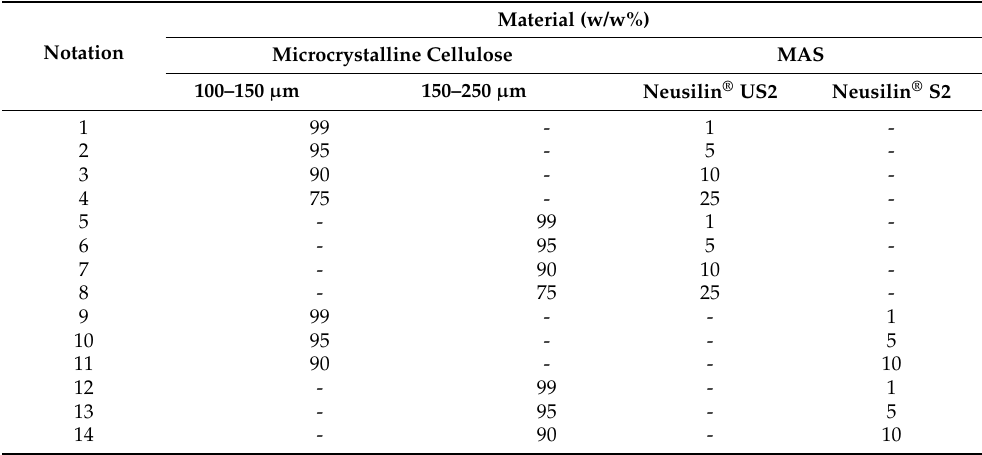
Table 1. List of prepared